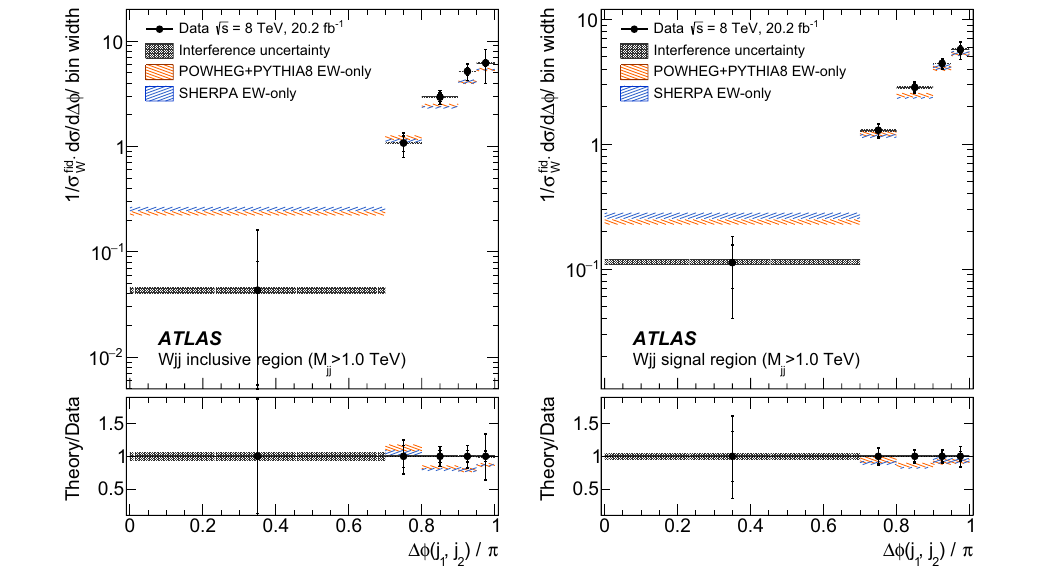
Fig. 28 Unfolded normalized differential EW W jj production cross sections as a function of the azimuthal angle between the two leading jets, for the inclusive and signal fiducial regions with M jj > 1 . 0 TeV.